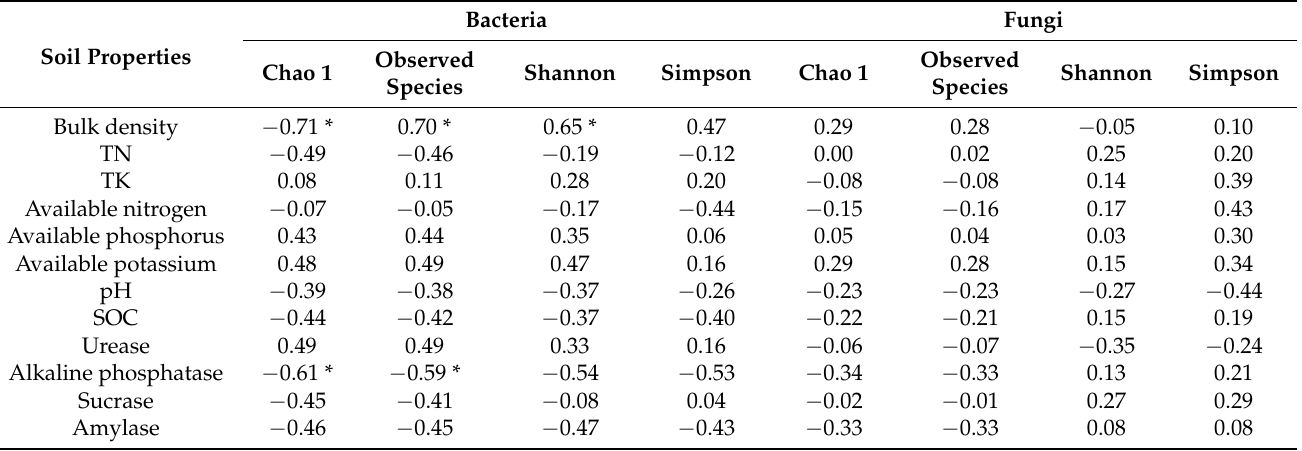
Table 3. Pearson correlation analyses of the relationships between soil physicochemical properties and microbial diversity.